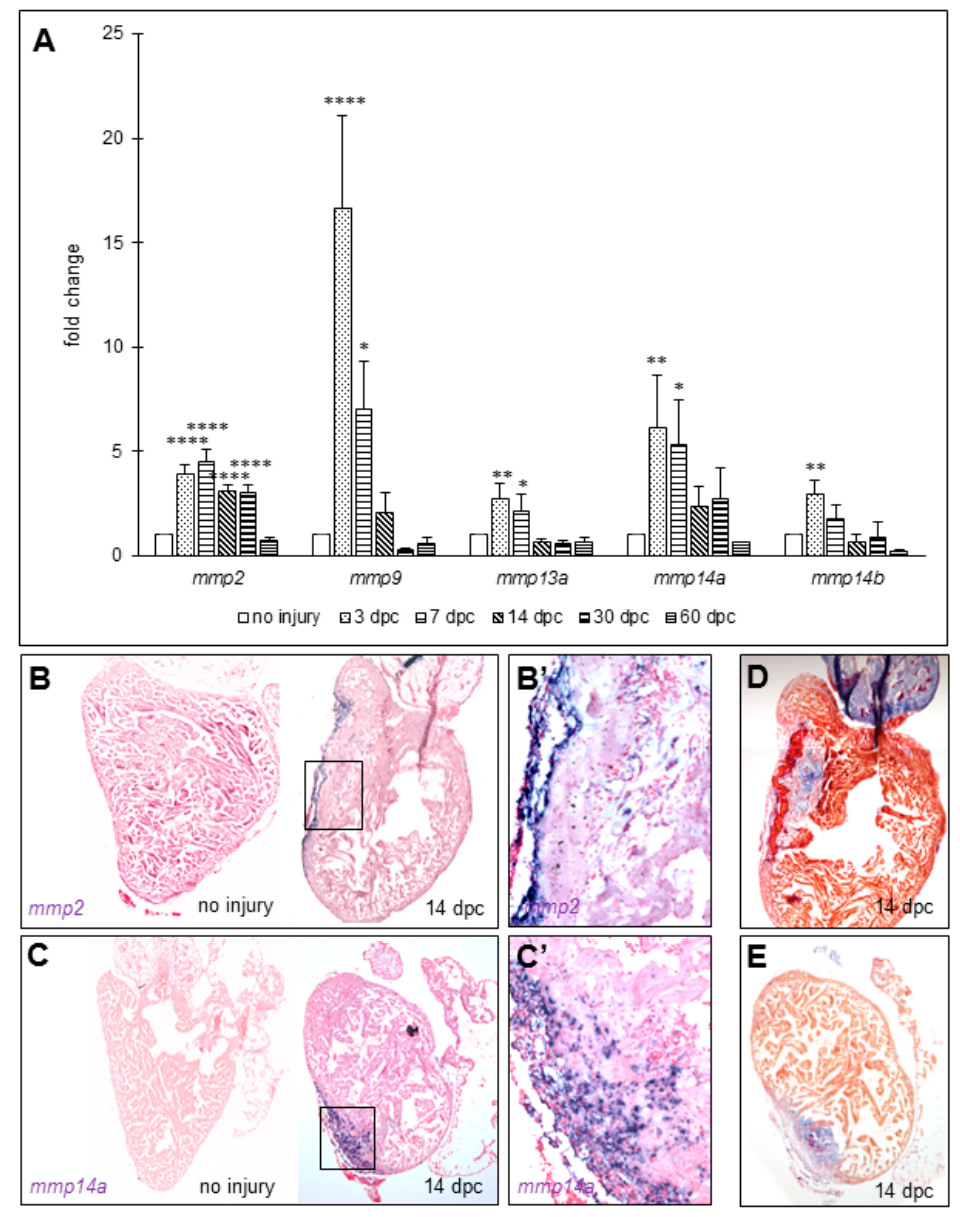
Figure 2. MMPs transcripts increase in zebrafish ventricles after cryoinjury. ( A ) RT-quantitative PCR for mmp2 , mmp9 , mmp13a , mmp14a , and mmp14b in ventricles at several time points after cryoinjury (six to eight ventricles per time point). Significant difference with uninjured hearts: **** p < 0.0001, ** p < 0.01, * p < 0.05. ( B , C ) in situ hybridization in uninjured and 14 dpc hearts of mmp2 ( n = 1 and 2, respectively) and mmp14a ( n = 2 and 2, respectively) transcripts respectively. ( B’ , C’ ) Magnification of the boxes in B and C, respectively. ( D , E ) AFOG staining on consecutive sections of 14 dpc hearts shown in ( B , C ) respectively for comparison with the wound area (fibrin in red, collagen in blue, and counterstaining in orange).